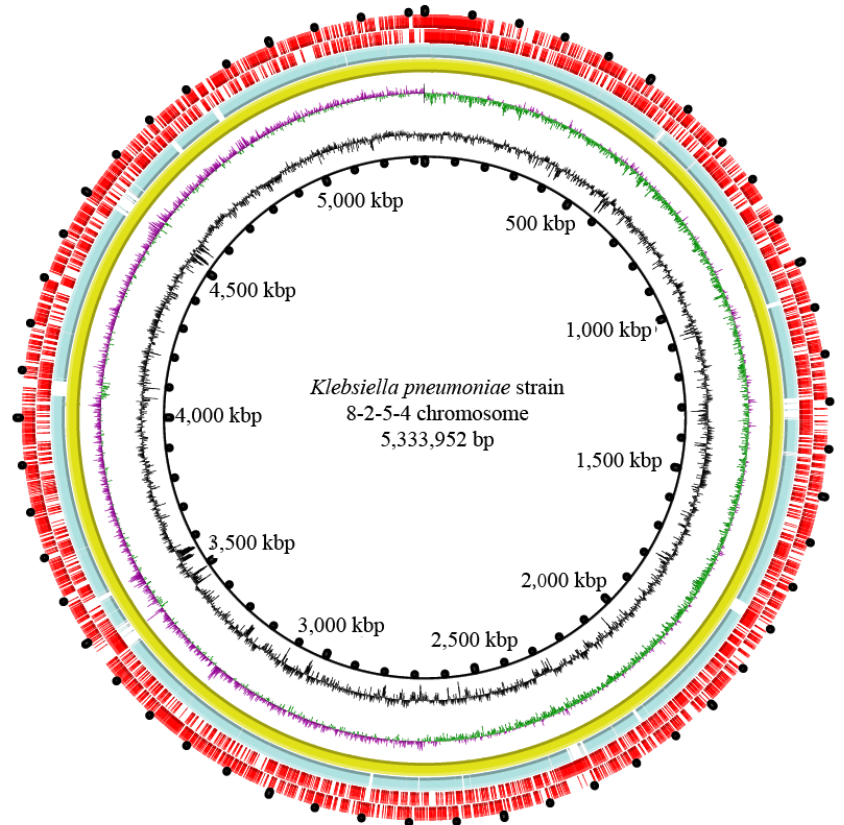
Figure 4. The genome circle map of K. pneumoniae 8-2-5-4 recovered from T. granosa . Circles from inside to outside were described in our recent research [48]. The reference genome was K. pneumoniae subsp. pneumoniae HS11286 (GenBank accession no. CP003200.1) (the third circle), and the draft genome sequence of K. pneumoniae 8-2-5-4 (the fourth circle) was determined in this study (GenBank accession no. JALJQQ000000000).